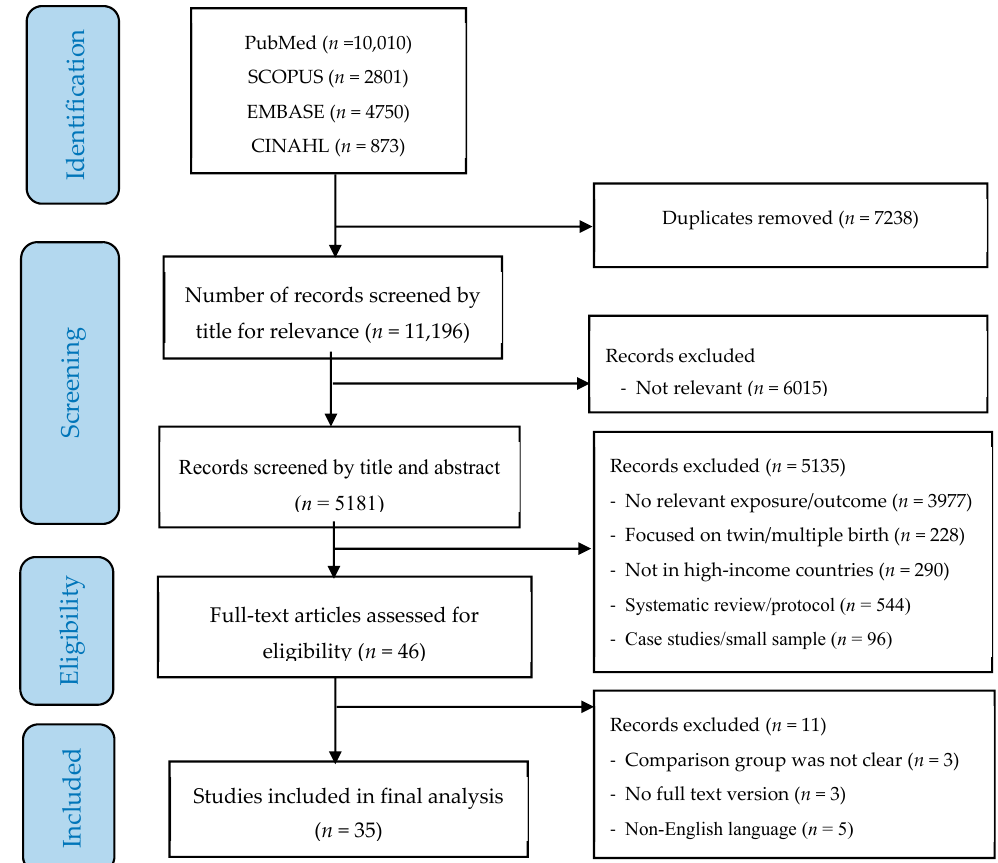
Figure 1. PRISMA flow diagram of screening and selection process.